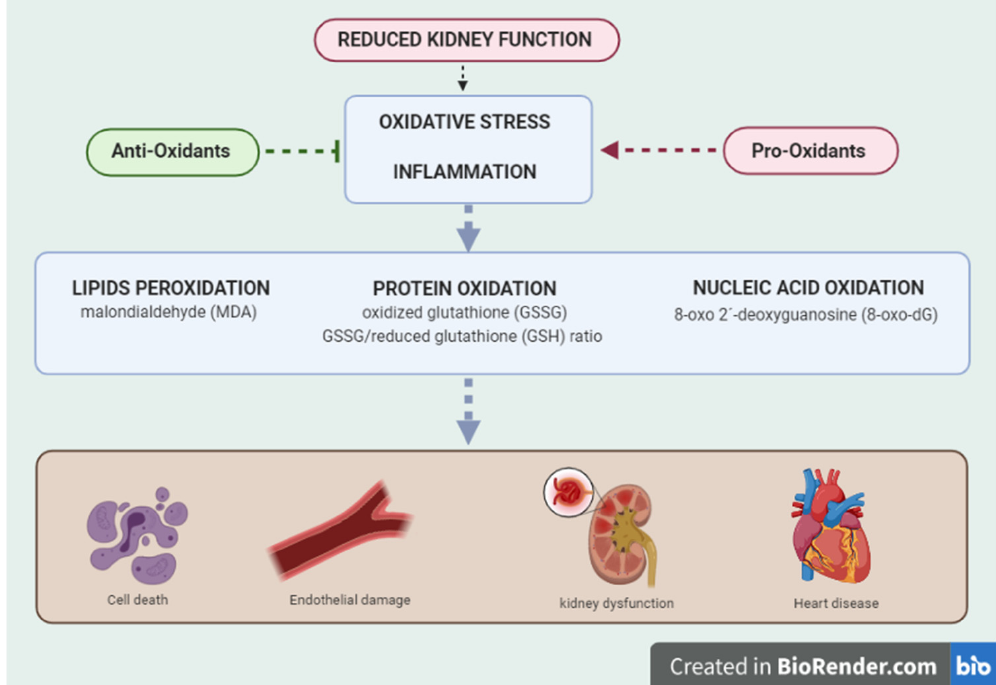
Figure 1. Oxidative stress and inflammation as key factors in the development of kidney and cardiovascular damage . The decline in kidney function is associated with an increase in oxidative stress and meta-inflammation. When this process become chronic, important metabolic changes and alterations in vascular renal hemodynamic stimulated chronic renal failure and cardiac dysfunction.